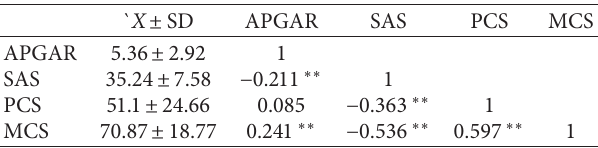
Table 2: Descriptive statistics and correlations of APGAR, SAS, PCS, and